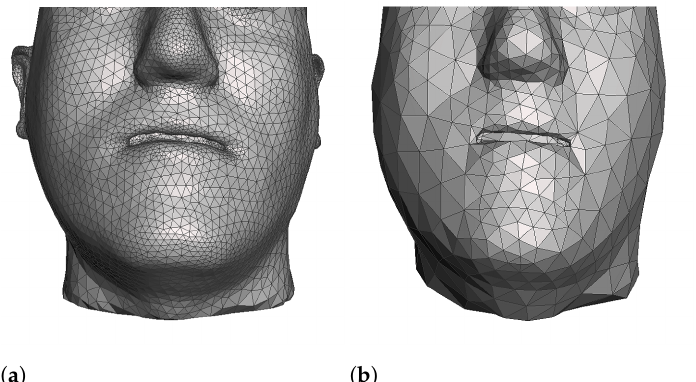
Figure 8. We simplify simulation meshes to retain the complexity that is sufficient for accurate planning, but which will minimize runtime cost. These images show examples where the raw mesh is simplified to 23,000 triangles ( a ) and 2600 triangles ( b ).